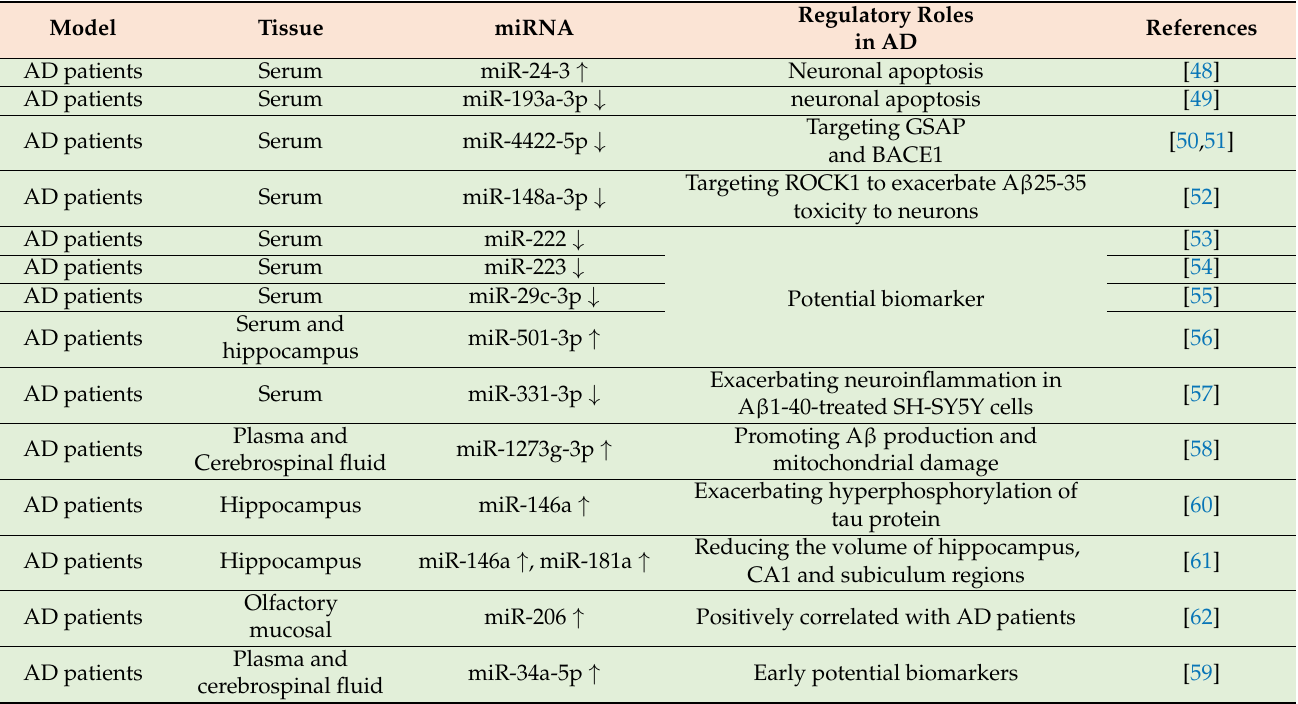
Table 1. The miRNAs involving the regulation of AD in clinical